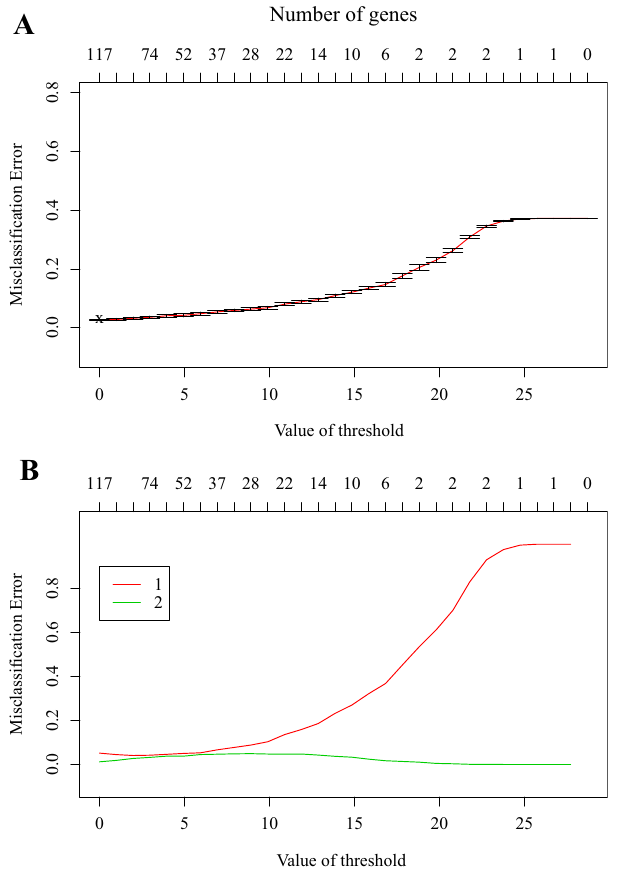
Figure 6. The predictive results for two clusters by the shrunken centroid algorithm. ( A ) The misclassification errors for predicting the two clusters with different parameters. (B) The misclassification errors for predicting the cluster 1 and cluster 2 with different parameters.